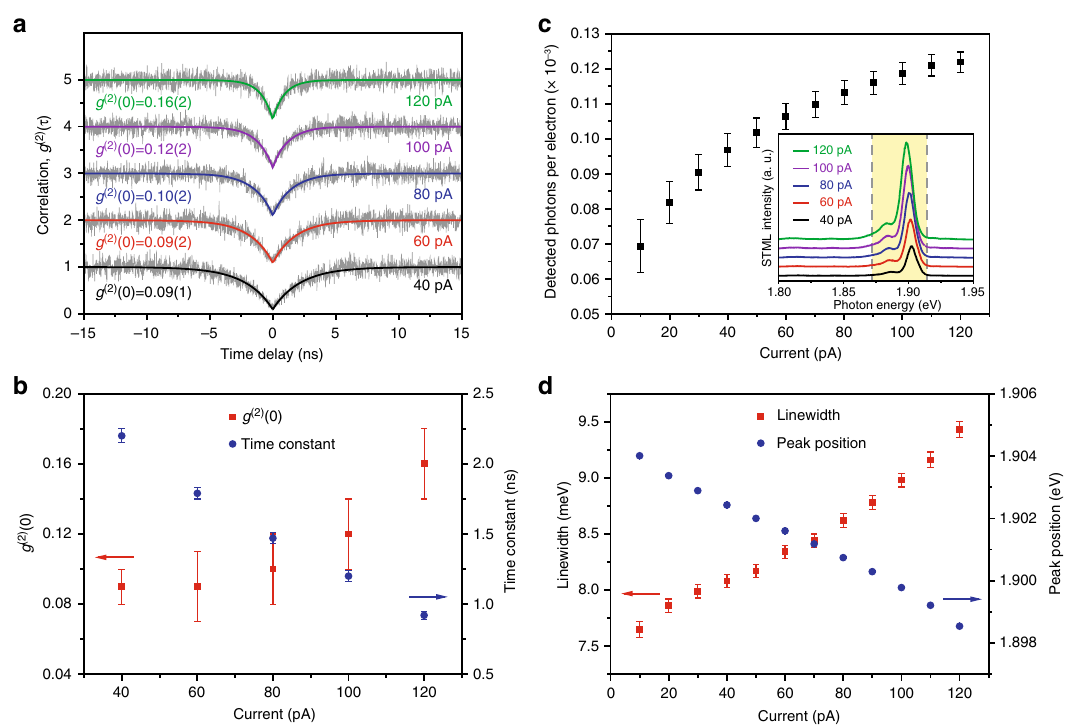
Fig. 5 Tip – molecule distance dependence of single-photon emission. a Second-order correlation functions measured above the same lobe of a single ZnPc molecule on 4 ML NaCl for different tunneling currents (40 – 120 pA) at a given bias of − 2.5 V. The upper curves have been upshifted by multiples of one for clarity. The start (stop) counts for the correlation measurements at 40, 60, 80, 100, and 120 pA are 24 kHz (20 kHz), 40 kHz (33 kHz), 59 kHz (48 kHz), 76 kHz (64 kHz), and 91 kHz (74 kHz), respectively, with a corresponding integration time of 9025, 3300, 1600, 1000, and 250 s. b Current-dependent g (2) (0) values ( red squares ) and time constants ( blue circles ) obtained from the single exponential fi t in a . The error bars represent the standard deviations obtained with the single exponential fi t. c Emission intensities detected by one SPAD normalized by the excitation current (i.e., detected photon counts per electron) ( black squares ). The error bars represent the standard deviations of the detected photon counts over 900 data points (for a period of 18 s with a 50 Hz sampling rate). The inset of c plots corresponding STML spectra acquired simultaneously during the HBT measurements in a (integration time: 30 s), showing an increase in emission intensity with the increased current. The highlighted yellow area indicates the detection range of the band-pass fi lters used here (1.872 – 1.915 eV). d Red shift of peak positions and linewidth broadening for the Q(0, 0) emission along with the increase of tunneling currents. The peak positions and linewidths are obtained by the Lorentz fi t to the observed STML spectra. The corresponding error bars represent the standard deviations obtained with the Lorentz fi